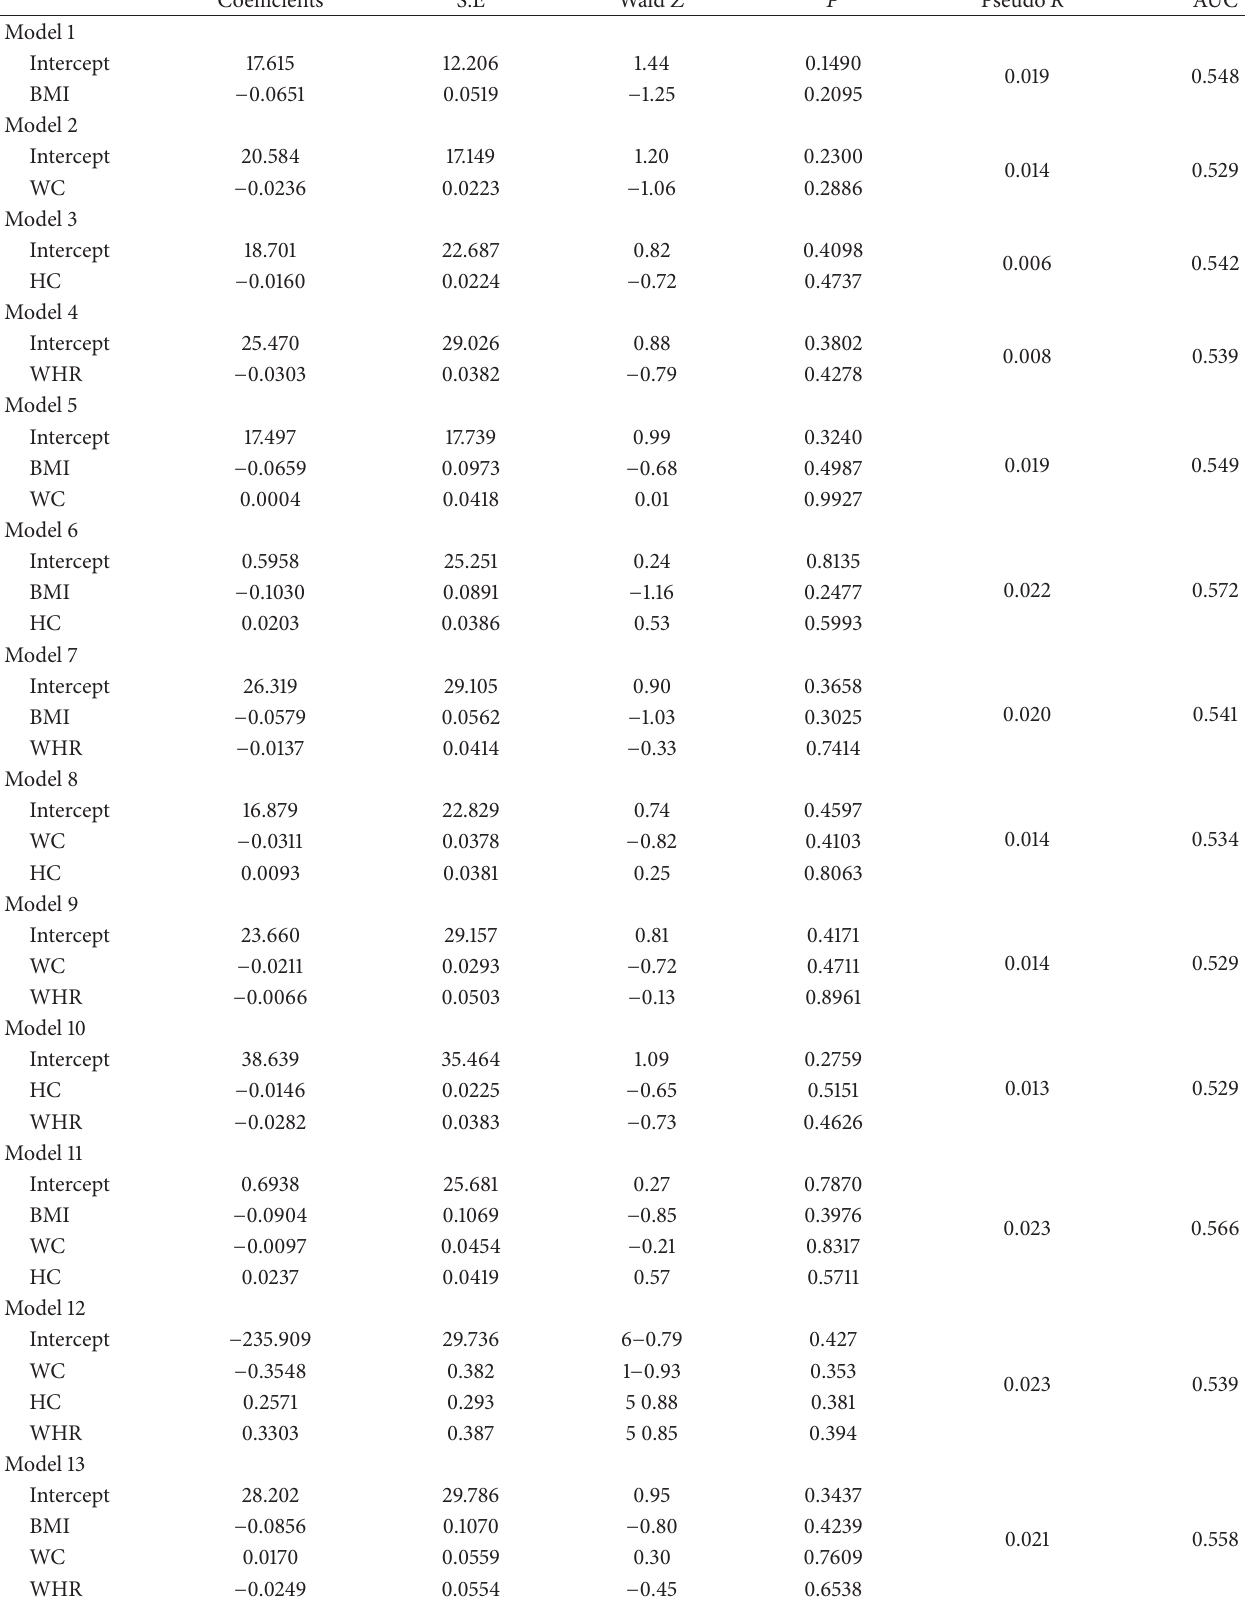
Table 3: Logistic regression results of women’s training